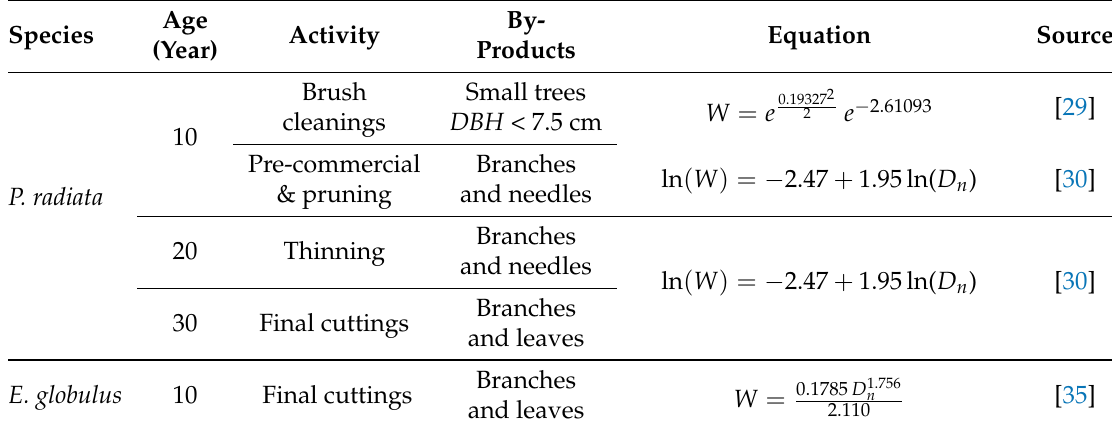
Table 3. By-products obtained in the forest treatments along the rotation of P. radiata and E. globulus .